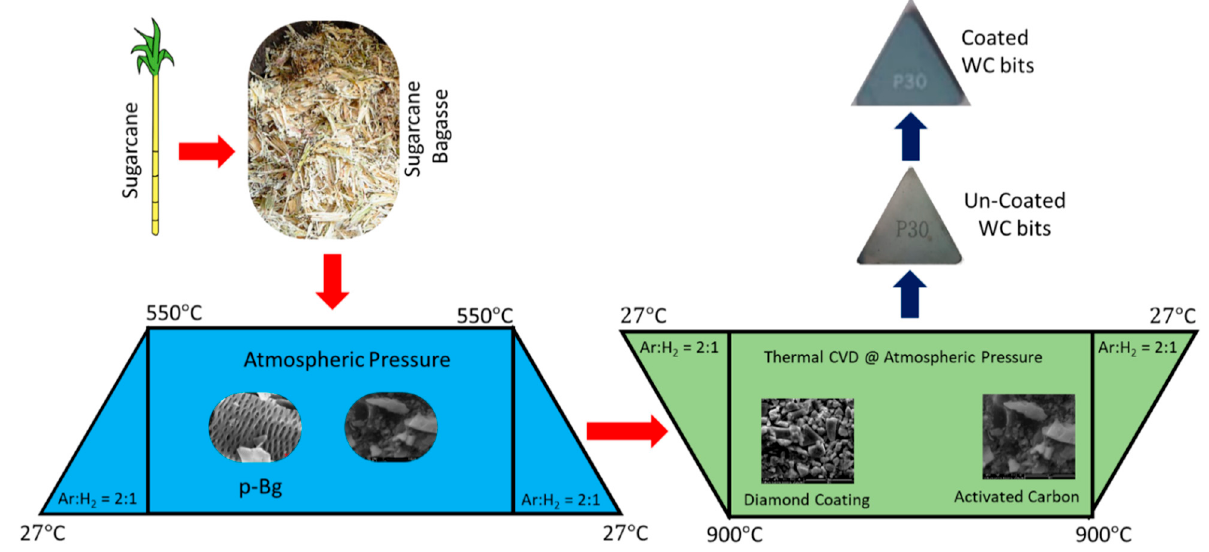
Figure 1. Process used for thermal chemical vapor deposition of DLC coating from pyrolysis of sugarcane bagasse [18,20,26]. Table 2. Levels of input parameters.